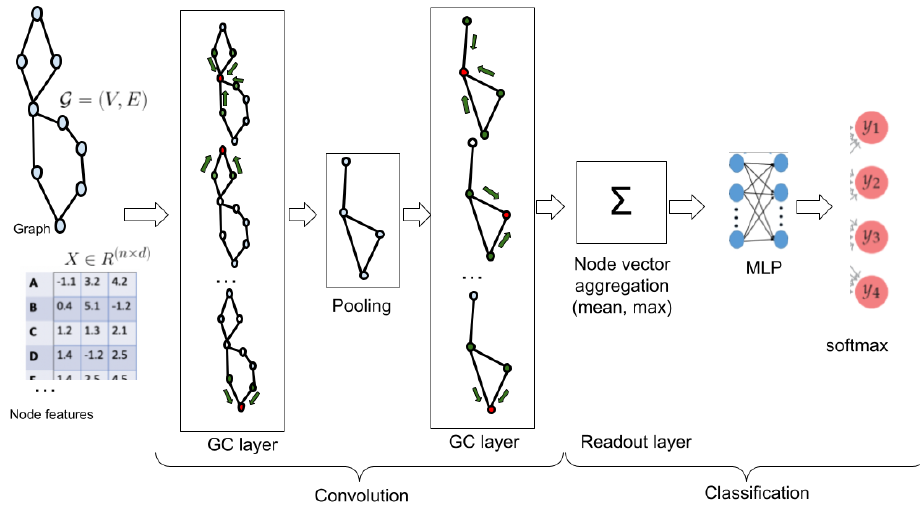
Figure 6. The architecture of GCNs in a generic graph classification